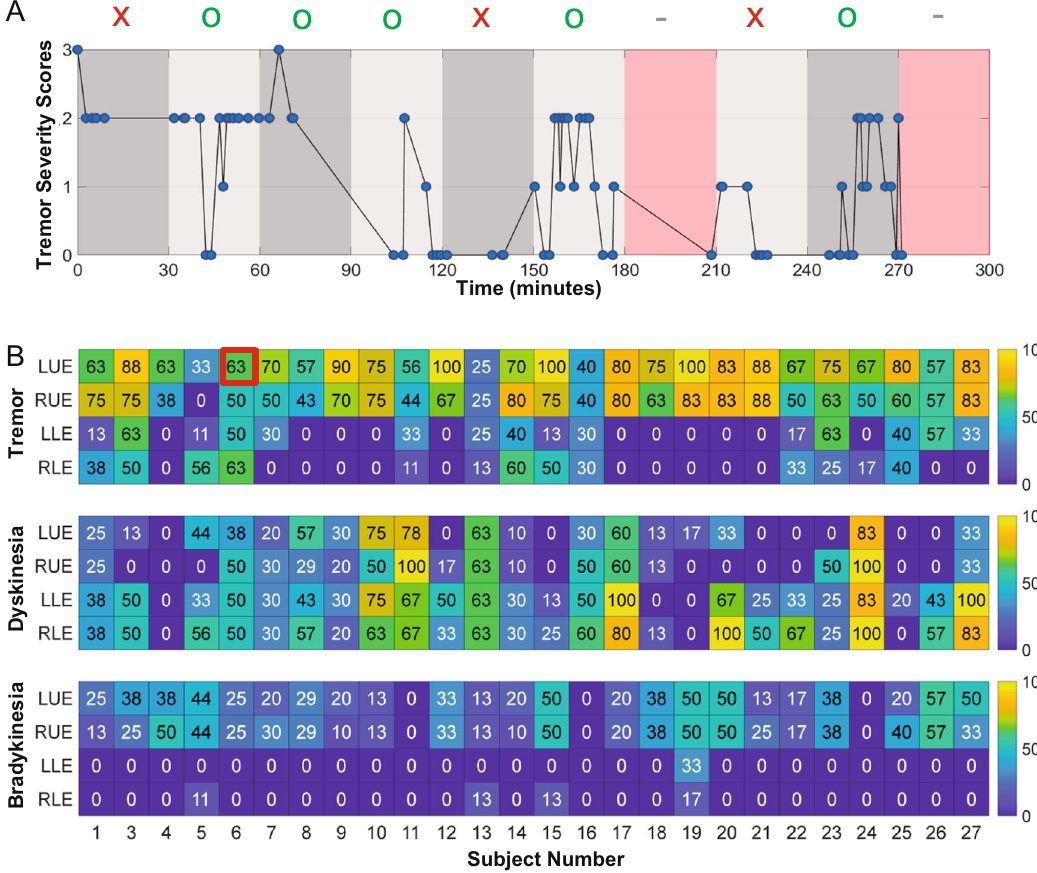
Fig. 4 Dynamics of motor symptoms across the medication cycle. a Time course of tremor severity from the left upper extremity (LUE) of one participant during the laboratory visit of study 3 (the value of 63% outlined in red in panel b was obtained from this time series). Tremor severity was obtained each time a prescribed motor task was performed (whether during one of the several scripted ADLs or the rest, gait and alternating hand movement tasks performed every 30 min). We considered each nonoverlapping 30-min interval during the visit, and excluded any period that did not contain multiple ratings (those periods highlighted red that have a gray dash above them). Among the remaining subset of eight 30-min intervals, we calculated the percentage of periods that contained at least two changes in symptom severity (marked with a green “ O ” above them). For example, in this participant, rapid fl uctuations in symptom severity are apparent in the second, fourth, sixth, and ninth periods. The remaining periods did not contain more than two changes (marked with a red “ X ” above them). b All participants; the percent of 30-min periods during the lab portion of study 3 during which at least two changes to symptom severity occurred. The cell of the matrix representation that is highlighted in red shows the percentage number of instances of at least two changes in tremor severity within a 30-min period derived from the plot shown in panel a